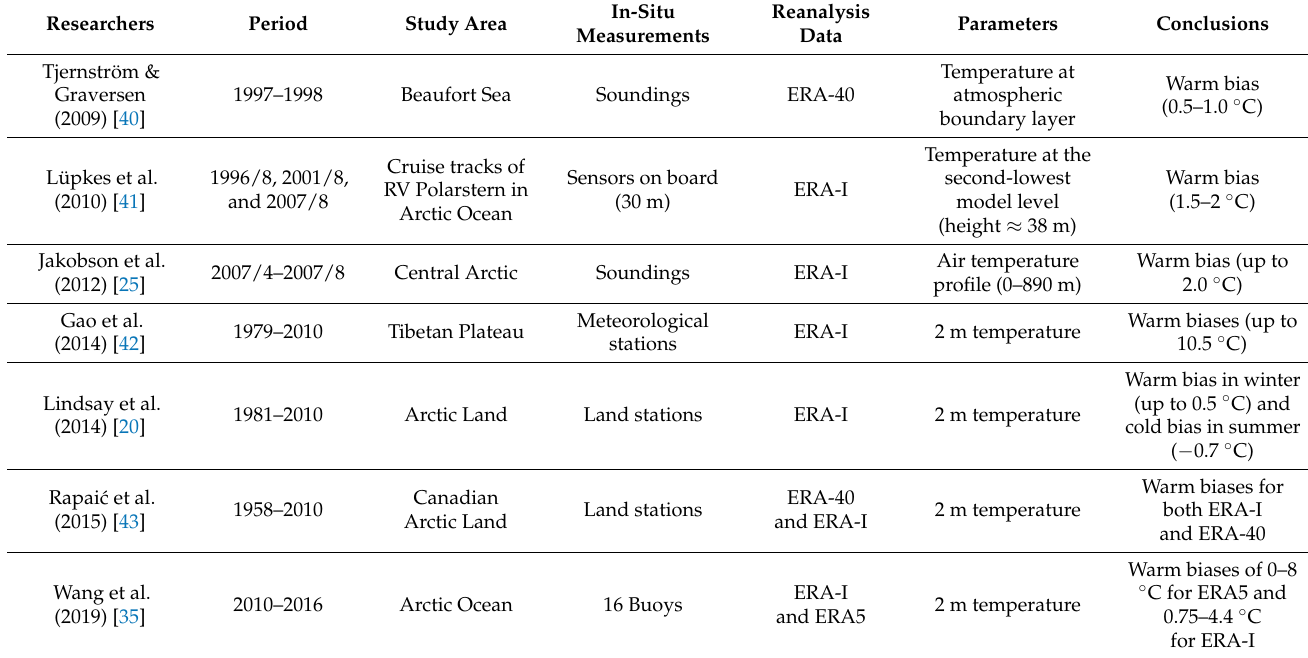
Table 1. Assessments of the temperature variables in the ERA series reanalysis datasets over the cold regions in the Northern Hemisphere in the previous studies. The research methods for these studies were similar and can be used to compare the reanalysis datasets with in-situ